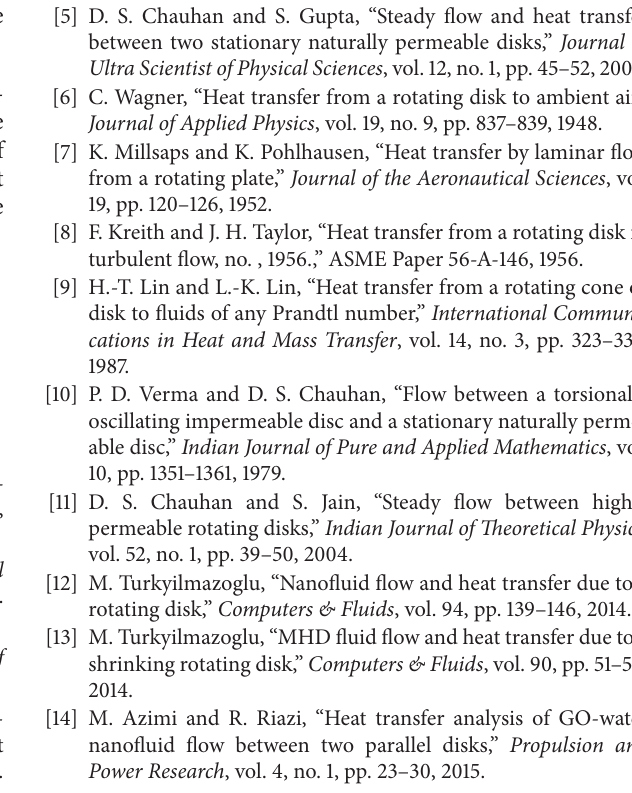
temperature and suction parameter also shows the same